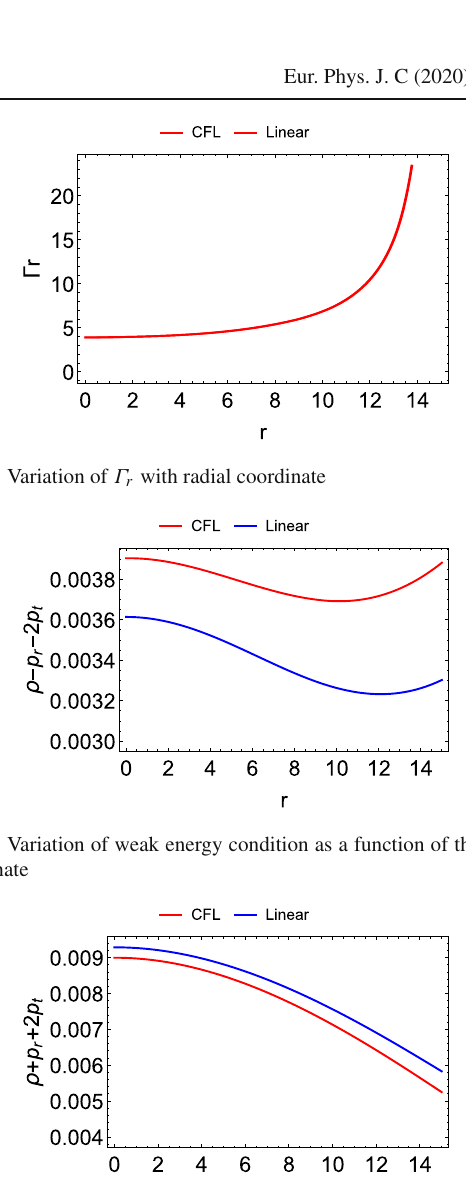
Fig. 6 Variation of tangential speed with radial coordinate